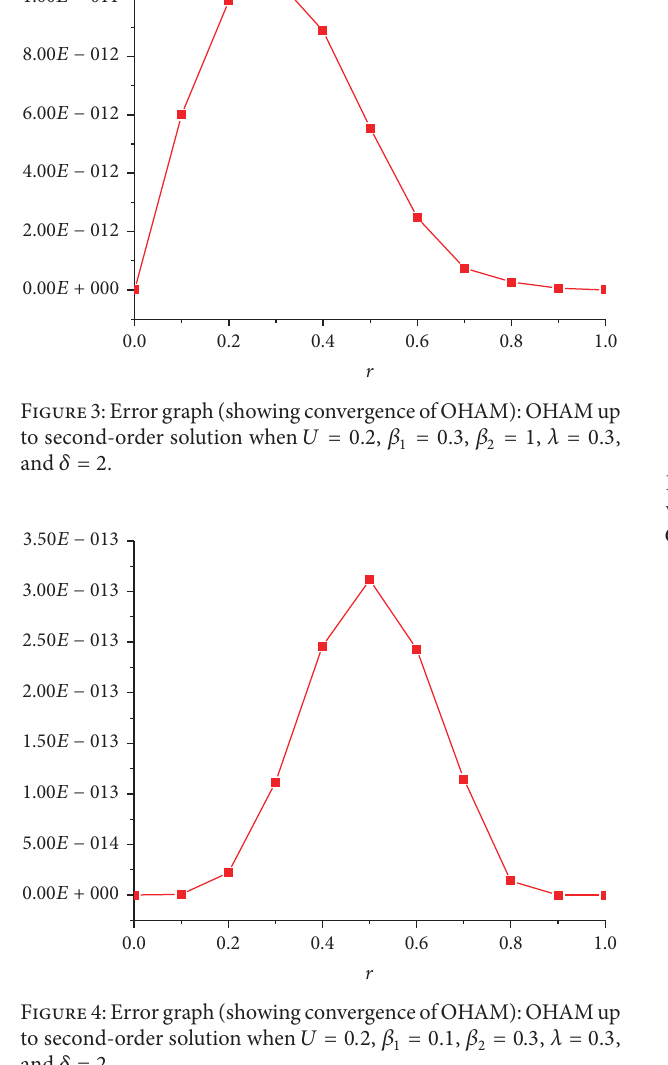
= −0.000248121 , 𝐶 2